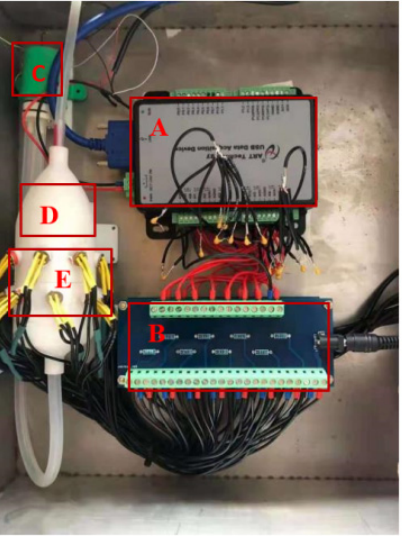
Figure 2. Electronic nose system diagram. ( A ) The data acquisition card; ( B ) the test circuit for the electronic nose; ( C ) the miniature air pump; ( D ) the sampling chamber; ( E ) the air-sensitive sensor array. Table 1. Application of sensors used in the sensor array.